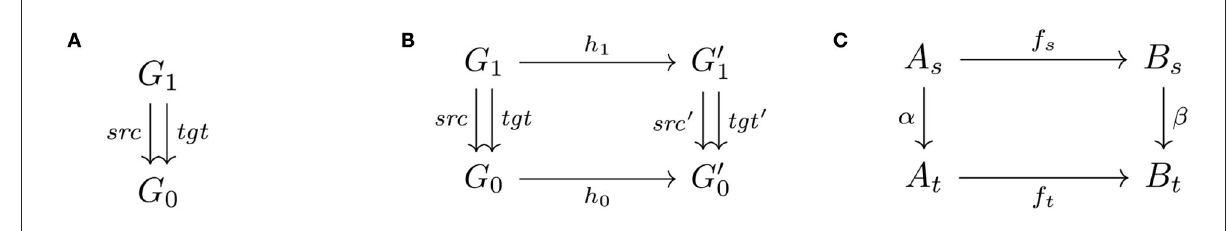
FIGURE5 (A) Graphs, (B) graph homomorphisms, and (C) arrow homomorphisms are expressed as